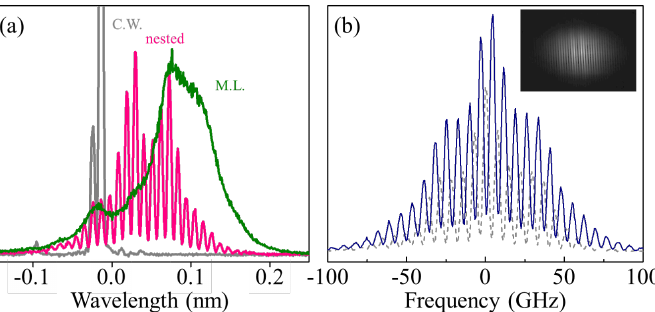
Figure 3. Single grating (1200 grooves/mm) spectrometer is used to resolve the 6.8 GHz free spectral range of the etalon. ( a ) shows how the spectrum of the laser is modified in different configurations. The green line is a mode-locked spectrum in the typical Ti:Sapph cavity without an etalon. The gray line is the continuous wave spectrum with a nested etalon, and the pink line is the mode-locked spectrum with a nested etalon. In ( b ) the solid blue line and the dashed line show how the optical spectrum visibly shifts as the etalon internal angle is tuned by about 10mrad. The inset of this plot is the raw data from the CCD showing the clear contrast of the Fabry–Perot etalon’s modulation of the optical